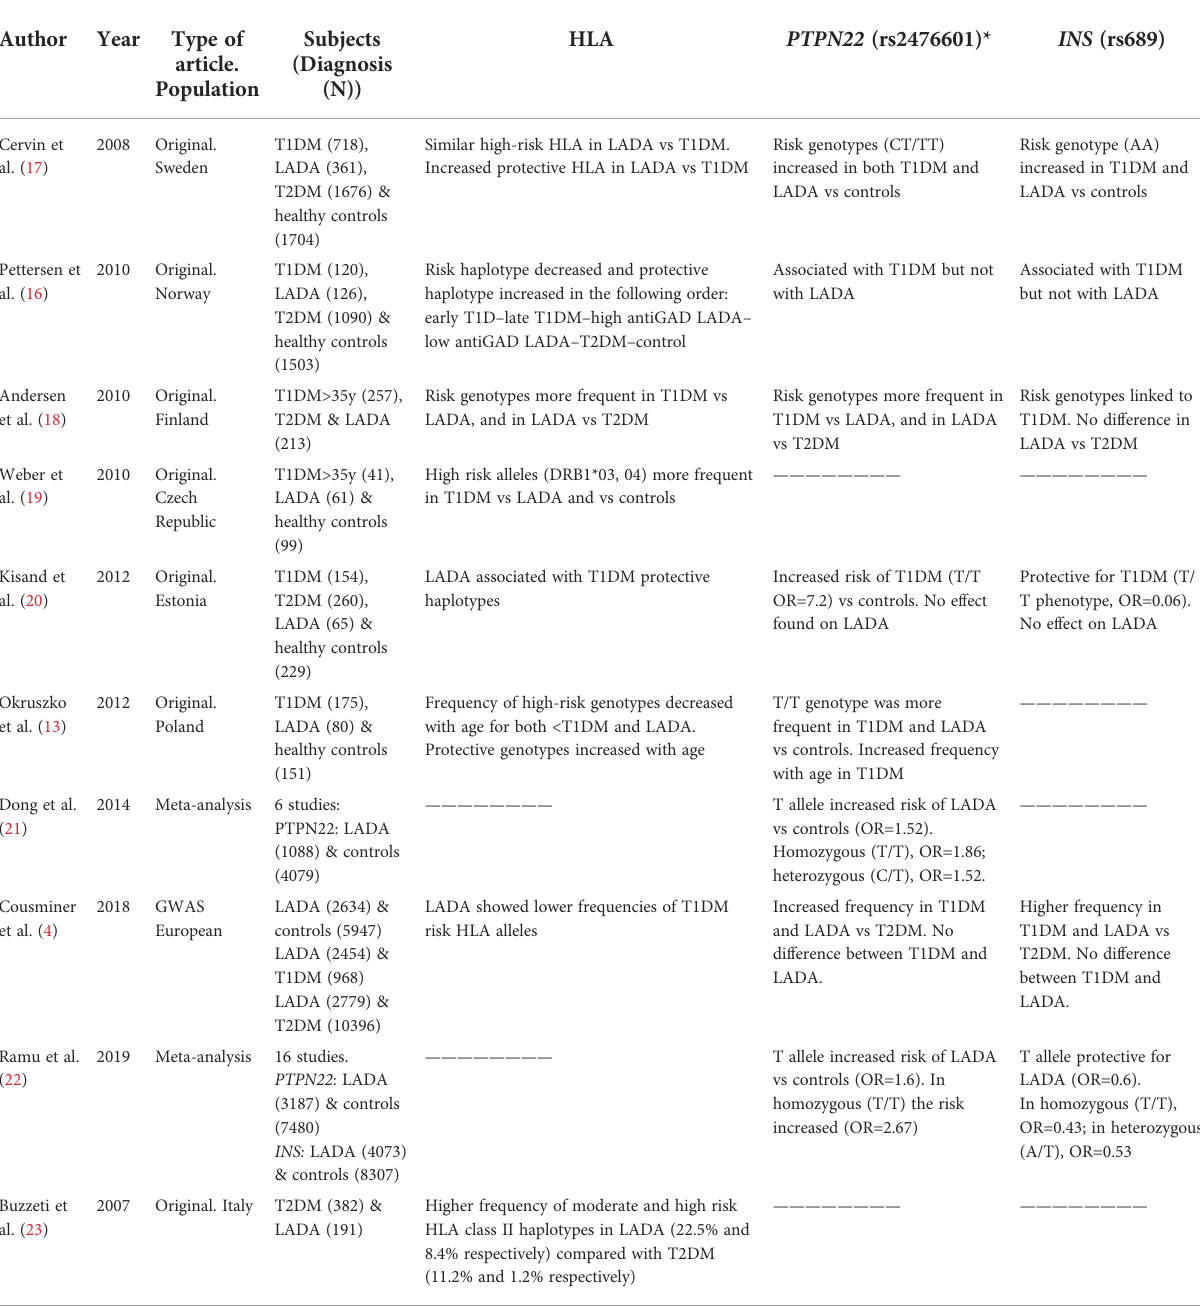
TABLE 5 Studies assessing HLA, PTPN22 and INS in LADA, type 1 and type 2